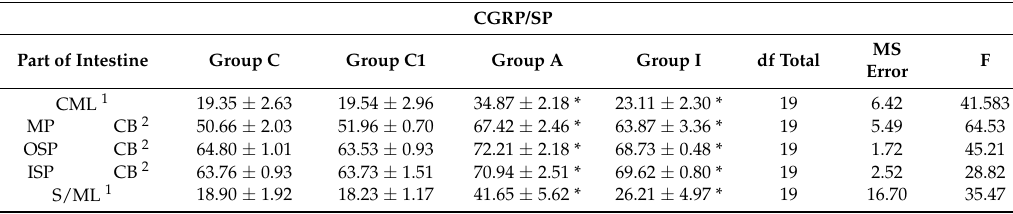
Table 2. Co-localization of CGRP with substance P (SP) in the enteric nervous structures of the porcine descending colon under physiological conditions (Group C), after “sham” operation (Group C1), after axotomy (Group A) and during inflammation (Group